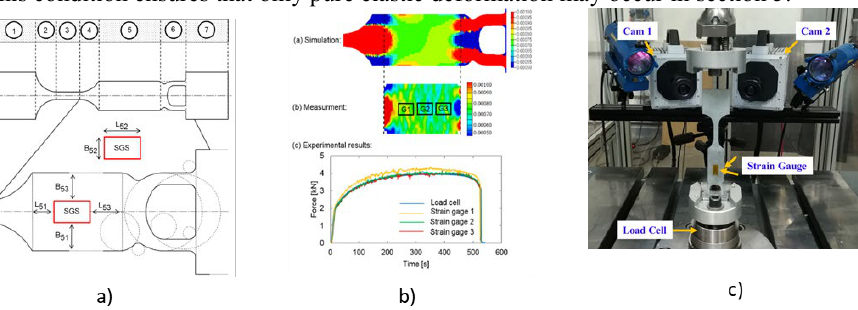
Figure 2: a) detailed characteristic of Gen. III sample; b) FE-optimized section 5 and 6 of a) and forces measured by load cell and strain gages; c) test